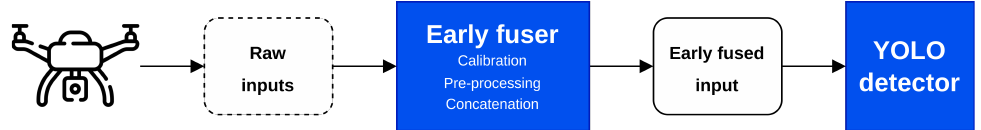
Figure 1. The early-fusion detection system high-level